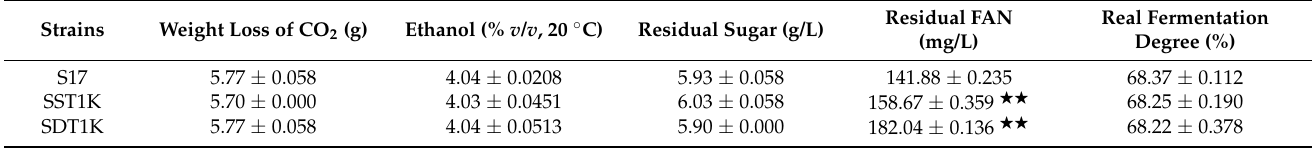
Table 2. Fermentation performances of the original strain S17 and its recombinants.